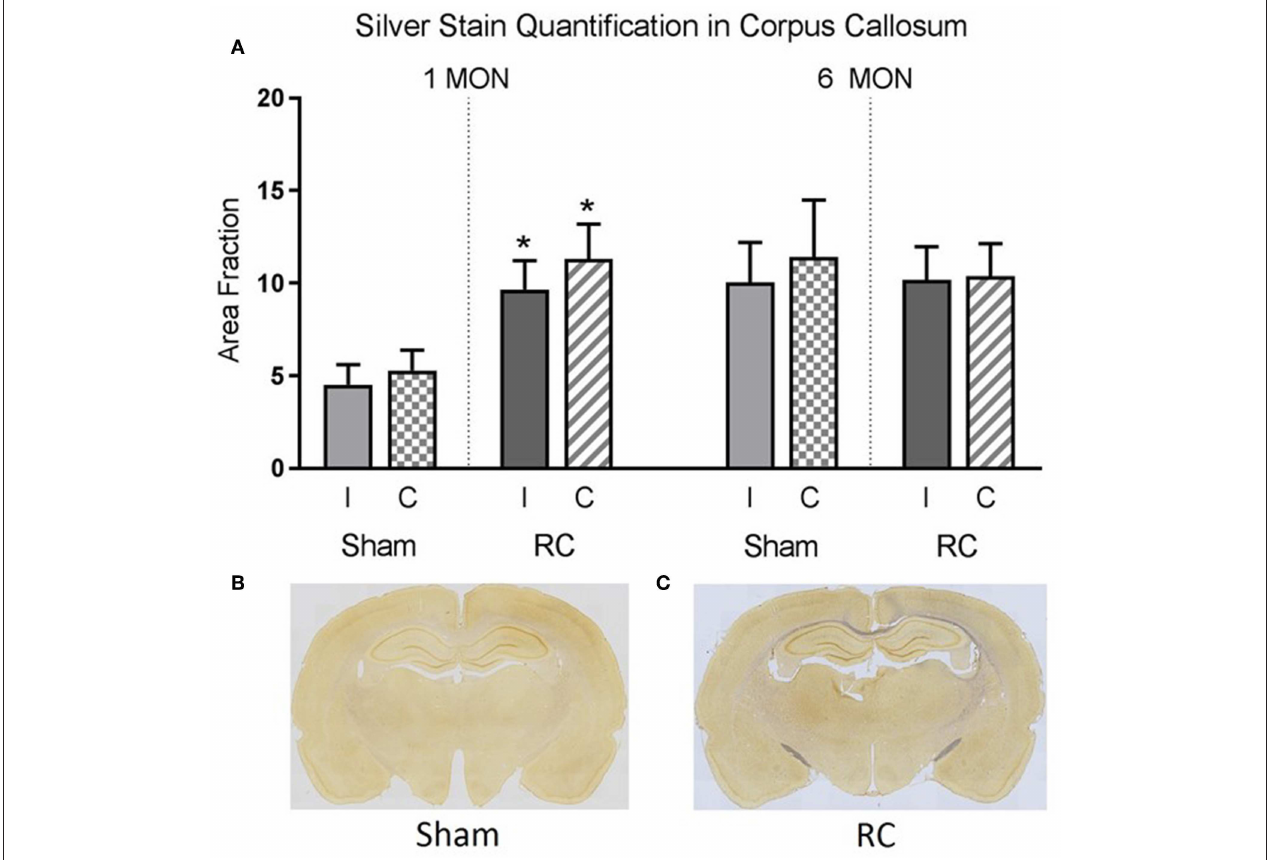
FIGURE 5 | Quantification of neurodegeneration by silver staining in the corpus callosum. At 1 month post-injury, rats sustained repeated concussive impacts (RC) showed significantly increased levels of silver staining in both ipsilateral (I) and contralateral (C) corpus callosum compared to sham controls (group n = 12; * p < 0.05) (A) . At 6 months post-injury, concussed rats (RC) and sham controls showed the same level of silver staining in the corpus callosum (A) . Representative coronal brain sections showed the intensity of silver stain in sham (B) vs. concussed rats (RC) (C) at 1 month post-injury (group n =